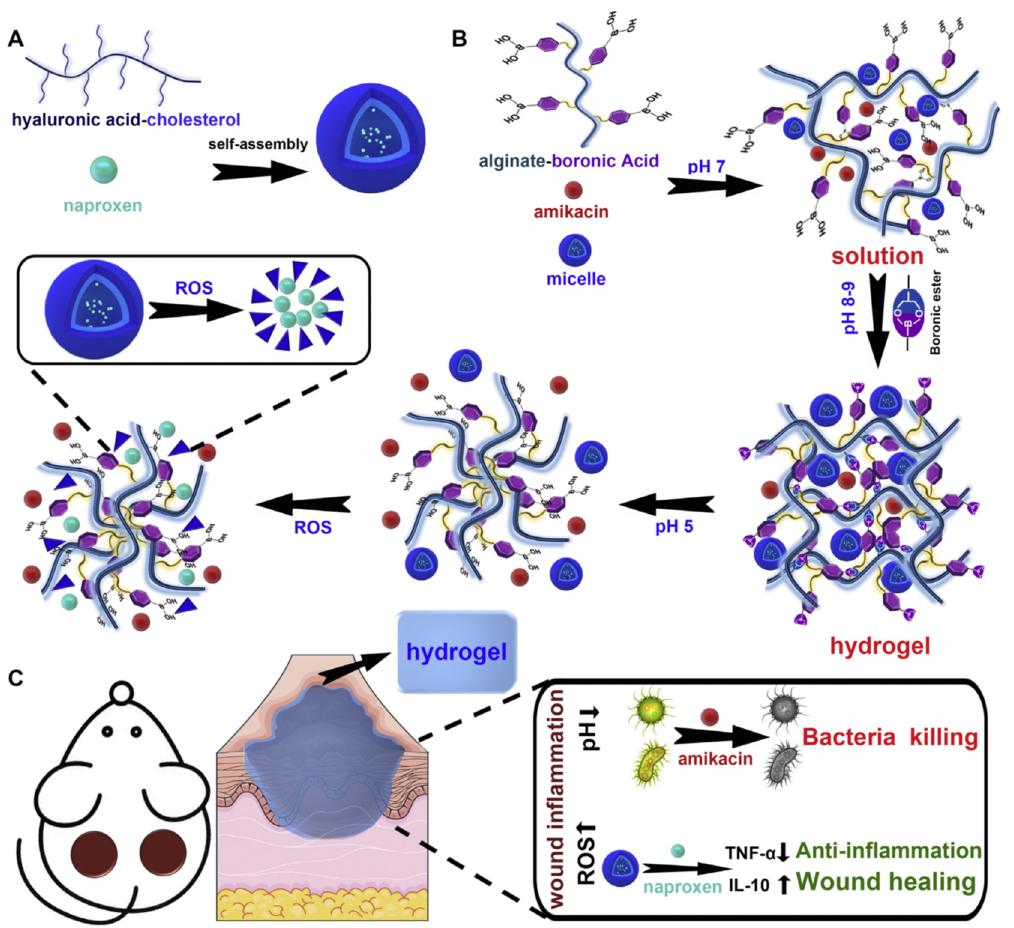
Figure 10. Schematic representation of ( A ) the self-assembly process ( B ) and the hydrogel formation. ( C ) Bactericidal and wound healing mechanisms in in vivo applications. Adapted with permission from [57].